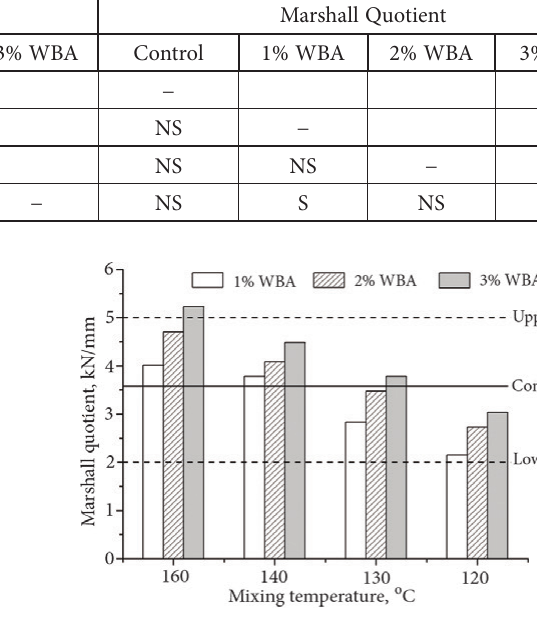
Figure 10. Marshall Stability of WMA mixes Figure 11. Marshall Quotient of WMA